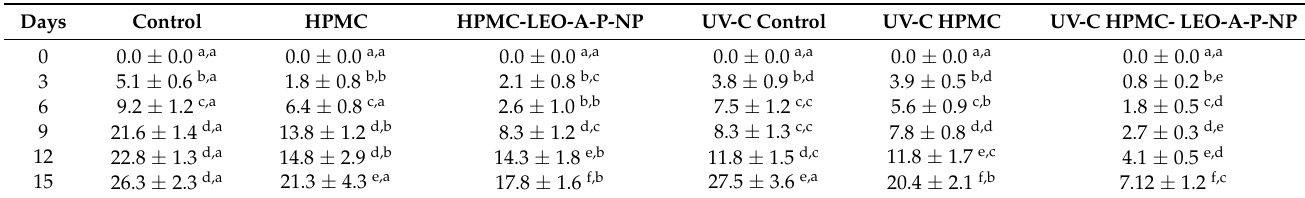
Table 2. Total color difference ( ∆ E) during storage of fresh-cut